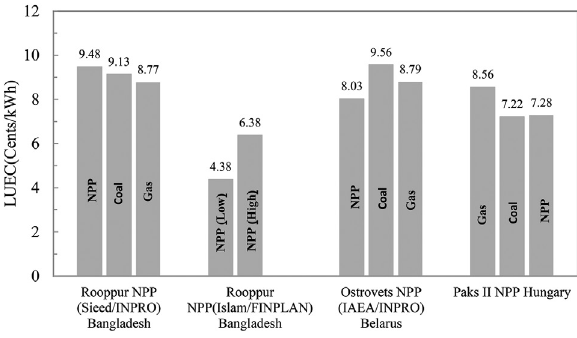
Figure 10. Comparison of LUEC of the three VVER-1200 Gen III+ NPP projects with two baseload power sources (IAEA/IN - PRO 2013, Paks II